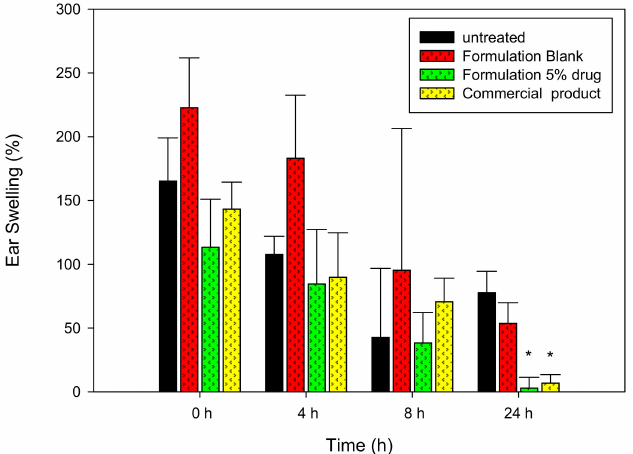
Figure 2. The ear-swelling (%) of mice treated with different formulations. * Significant difference shown when compared with untreated samples ( p < 0.05).